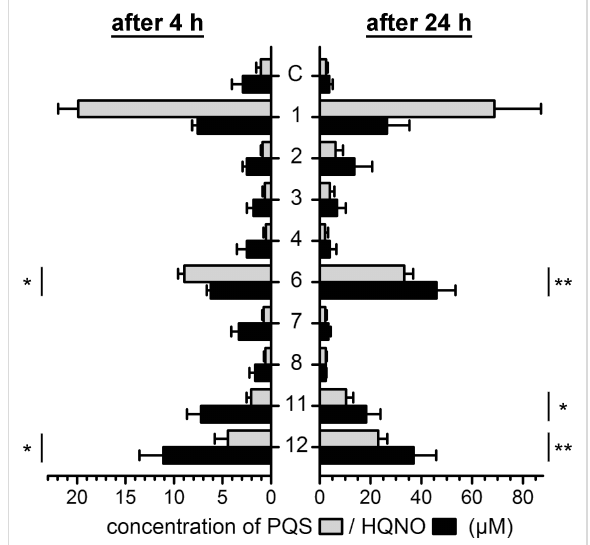
Figure 3: Impact on AQ quorum sensing by the newly synthesized AQ derivatives. Cultures of P. aeruginosa PAO1 were supplemented with 100 µM of AQs ( 1 – 12 ) or an equal amount of DMSO as the control (C), and the concentrations of PQS (grey bars) and HQNO (black bars), as readout of the signal-induced upregulation of AQ biosynthesis, were measured at an early (after 4 hours; left) and a late stage (after 24 hours; right) of quorum sensing. Because P. aeruginosa is able to convert HHQ ( 1 ) to PQS, the PQS data measured after addition of 1 to the cultures represent a combination of auto-induction of AQ synthesis by HHQ, and biotransformation of HHQ to PQS. However, HHQ is not a biosynthetic precursor of HQNO. Means and standard errors of five biological replicates are shown. One-way ANOVA was used for statis- tical analysis, and significant differences compared to the control (C) are indicated (* P < 0.05, ** P <